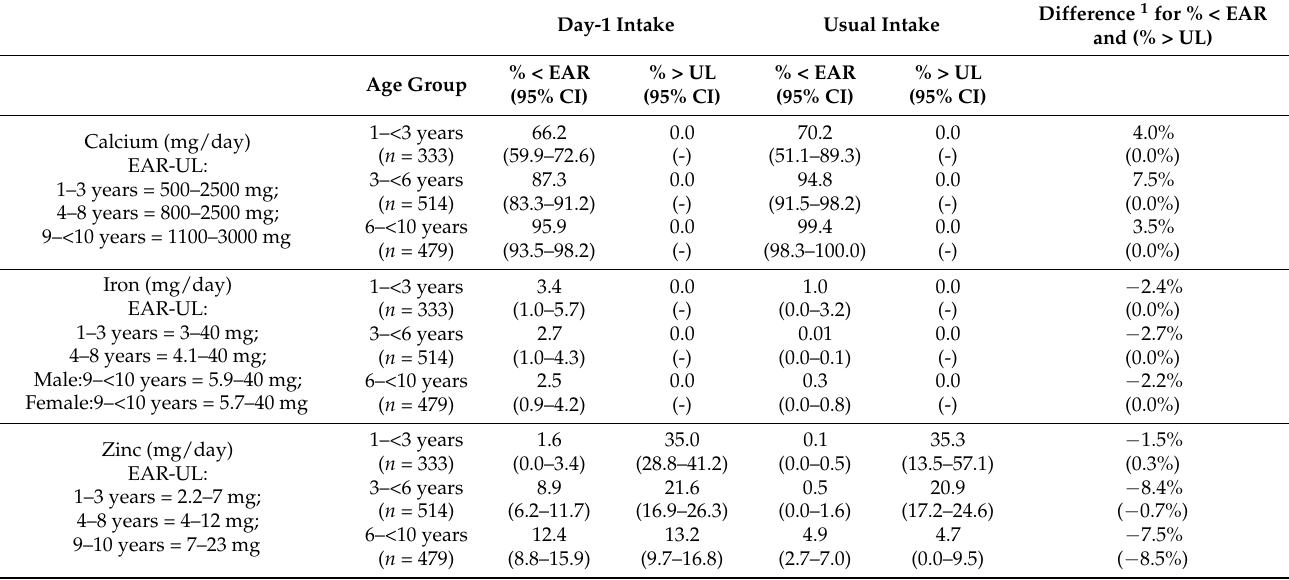
Table 3. Comparison of percentage below EAR and above UL cut-points for risk of calcium, iron and zinc deficiency and excess respectively, by age group. Day-1 Intake Usual Intake